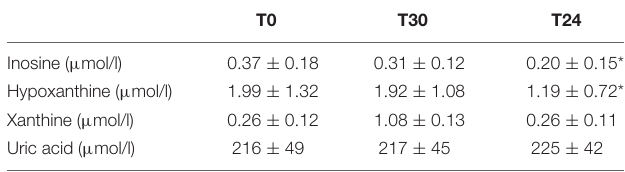
TABLE 3 | Concentration of inosine, hypoxanthine, xanthine, and uric acid in plasma before (T0); 30 min after (T30); 24 h after cryostimulation